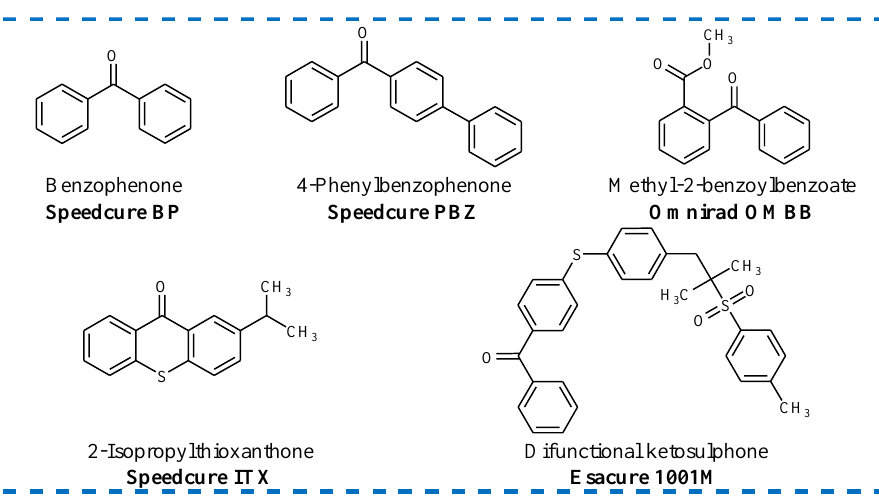
Figure 3. Examples of commonly used type II photoinitiators.